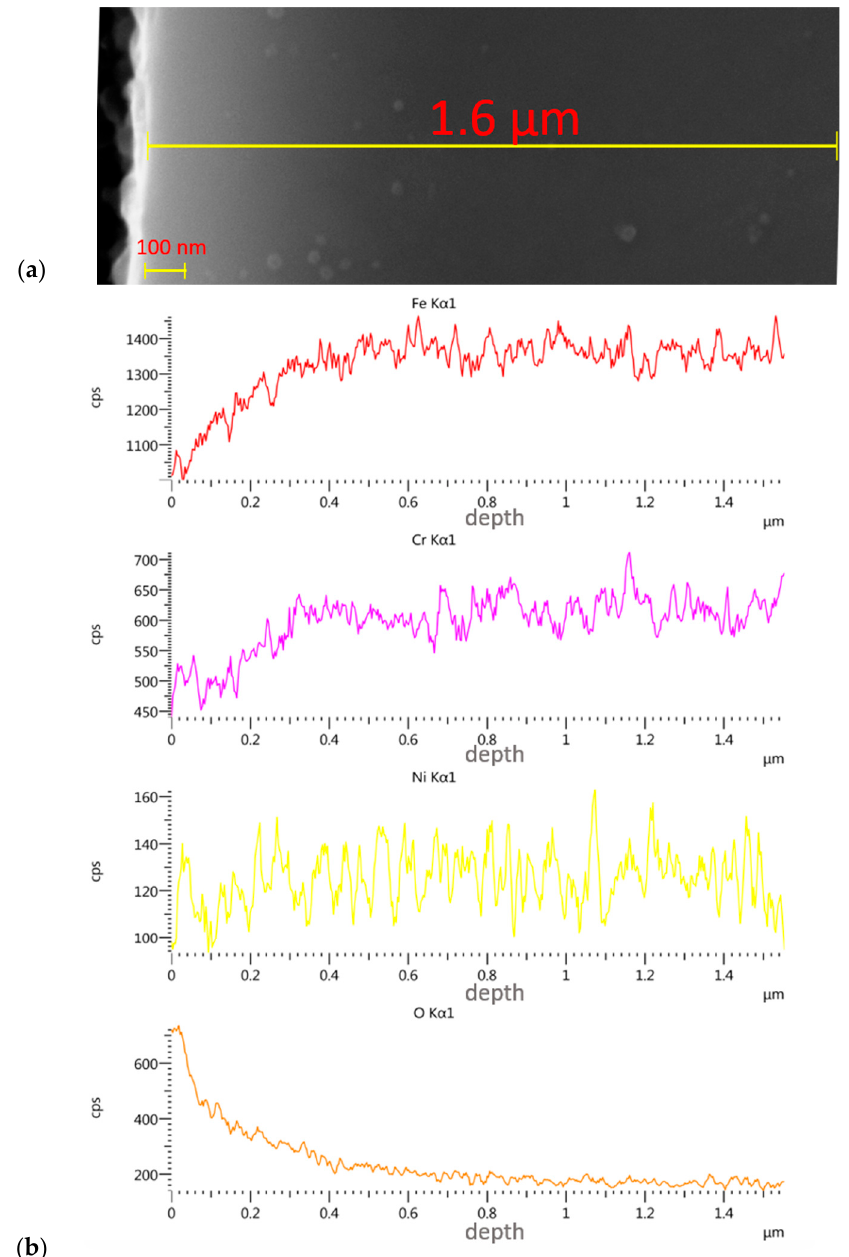
Figure 8. SEM micrograph of the cross-section of steel 316L sample implanted with oxygen ions ( a ) with linear EDS analysis of elemental distribution ( b ).